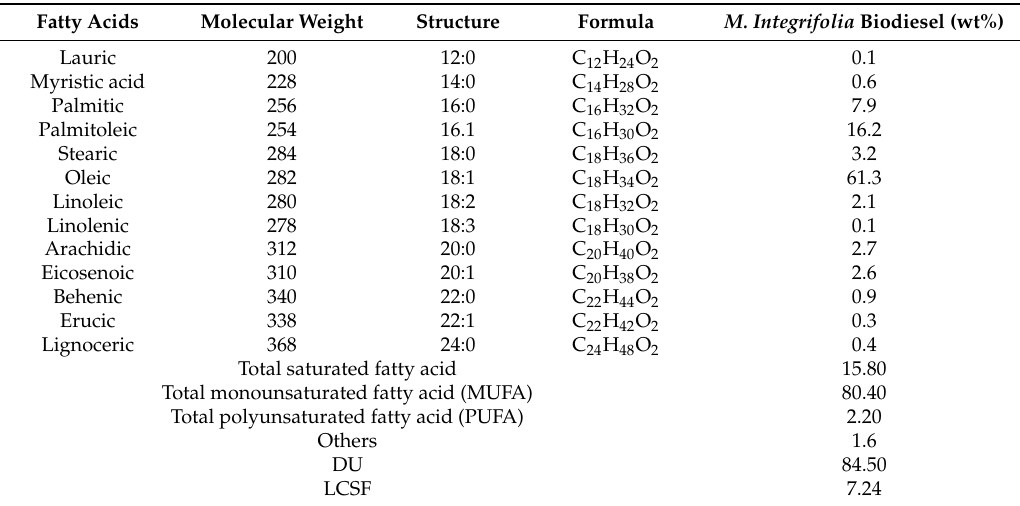
Table 5. Fatty acid composition of macadamia biodiesel. DU: degree of unsaturation; LCSF: long chain saturated factor.